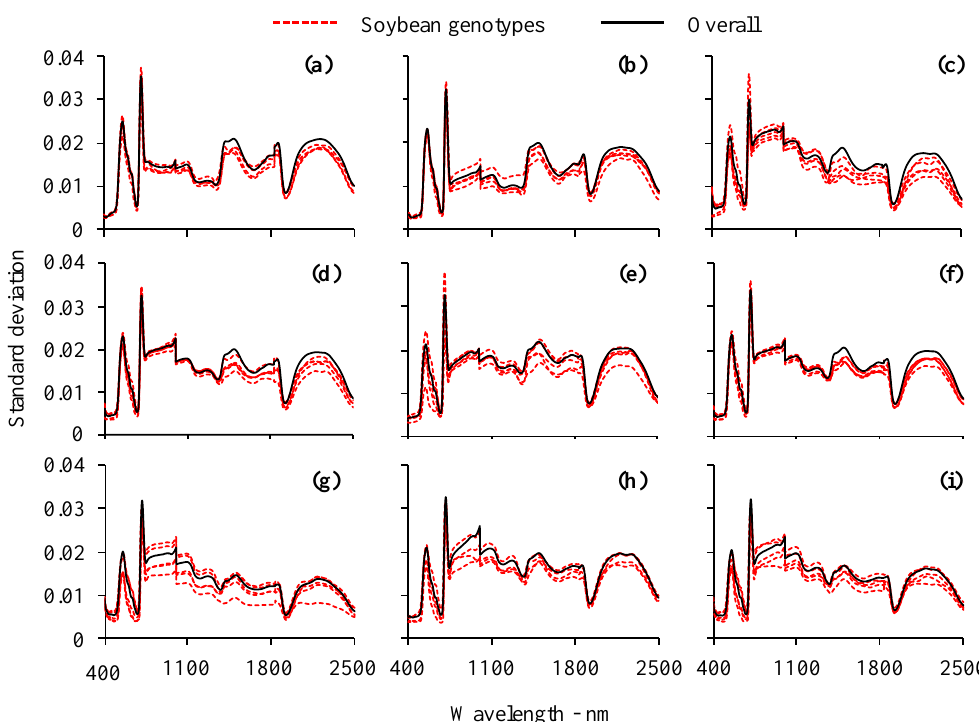
Figure 7. Standard deviation of soybean genotypes and overall standard deviation of Embrapa 2016/2017 ( a ), Embrapa 2017/2018 ( b ), Embrapa 2018/2019 [I] ( c ), Embrapa 2016–2019 ( d ), Unoeste 2018/2019 [I] ( e ), Embrapa 2016–2019 + Unoeste